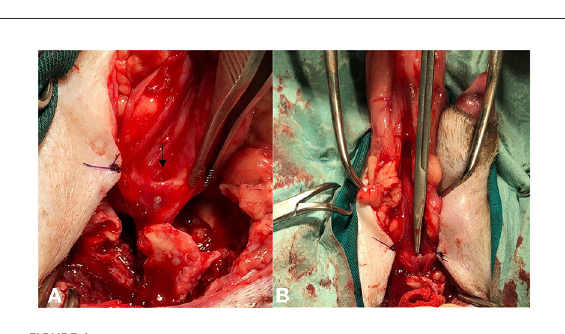
FIGURE4 (A) Intraoperative image of the opening of the ectopic urethra (black arrow) after urethrotomy. Note the urinary catheter ascending from the pelvic urethra. (B) Note the Metzenbaum scissors entering the remnant of the ectopic